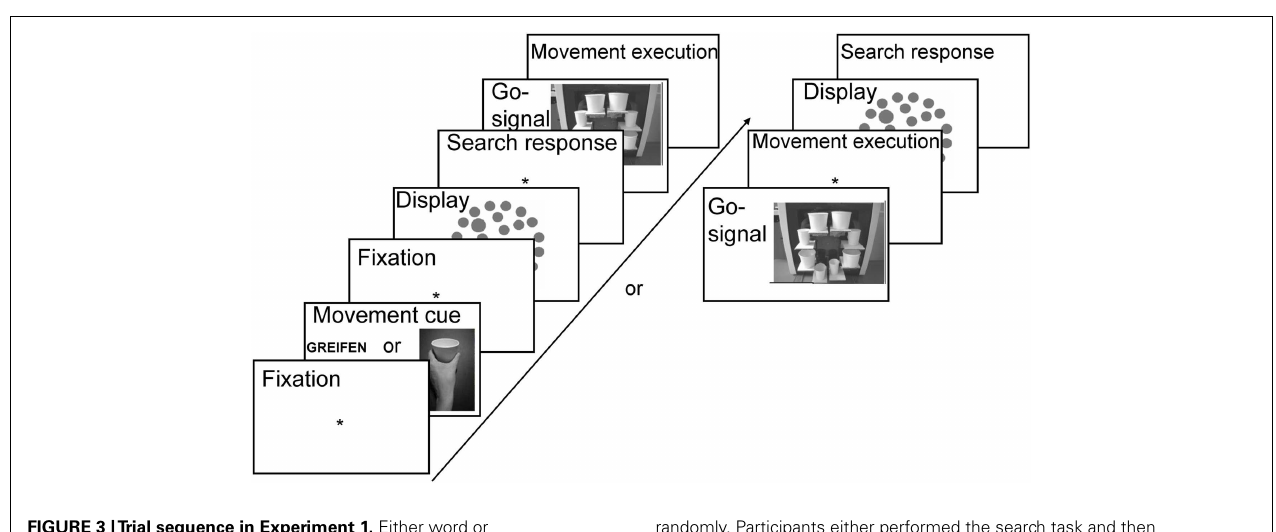
FIGURE 3 |Trial sequence in Experiment 1. Either word or picture cues informed participants about the required action type. The order of search task and movement task were intermixed